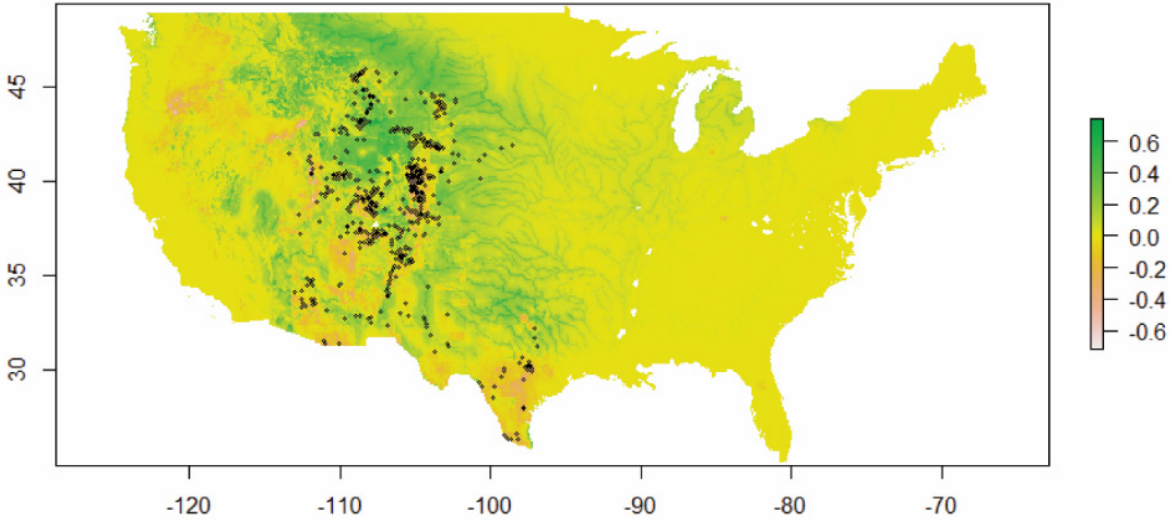
Figure A5. The difference (climate-only model–full model) in ROR shown to illustrate the direction and spatial variability between current condition predictions. Occurrence locations are shown in black.